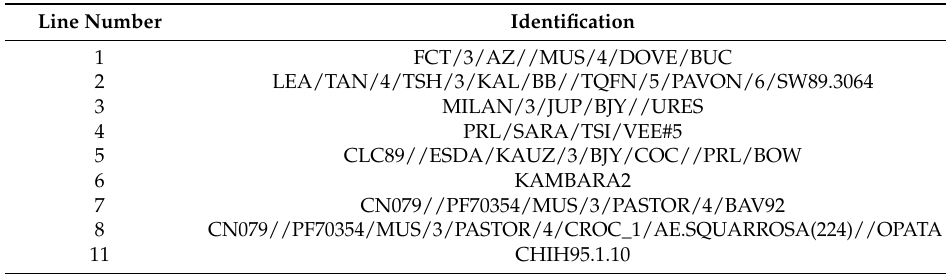
Figure 1. The mean grain yield of nine lines of wheat grown at elevated and ambient CO 2 ( a ), and the ranking of grain yields at elevated and ambient CO 2 ( b ). Linear regressions had an R 2 value of 0.200 for yield, and 0.267 for the ranking of yields, which are not significant at p = 0.05. The numbers identify the lines, which are listed in Table 3. Table 3. The nine lines of wheat tested in the second experiment. All lines are from the wheat association mapping initiative breeding population developed by Centro Internacional de Mejoramiento de Maíz y Trigo [15].